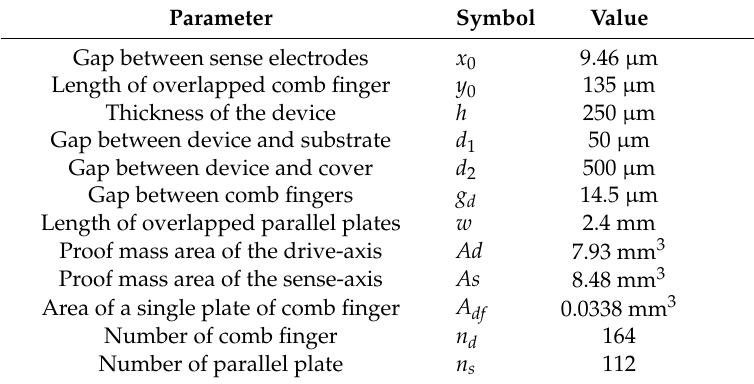
Table 1. Parameters of the gyroscope.